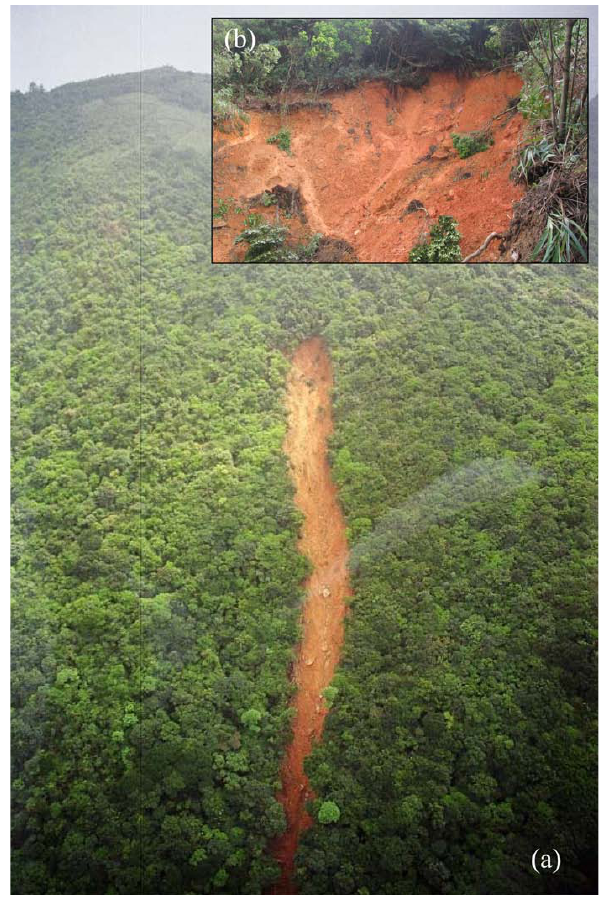
Fig. 2. The August 2005 debris flow: (a) oblique aerial view; (b) general view of the main scarp (modified after MGS,